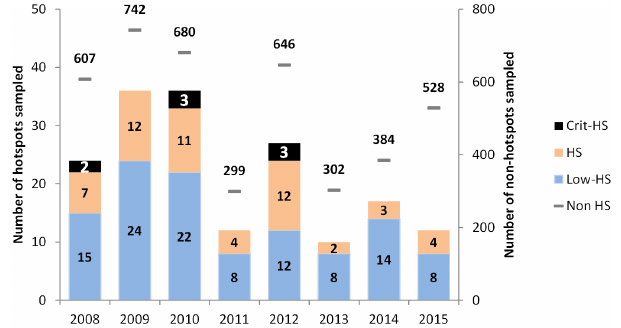
Figure 6. Overview of the categorisation of the measurements of the water temperature at the tap per year (HS: